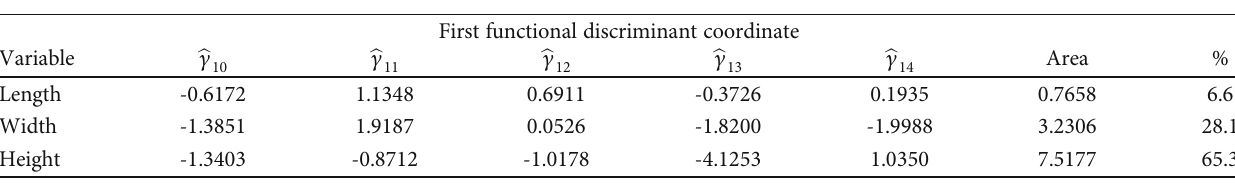
Figure 4: Weight functions for the fi rst (a) and second (b) functional discriminant coordinates. Table 1: Values of coe ffi cients of the vector weight function.